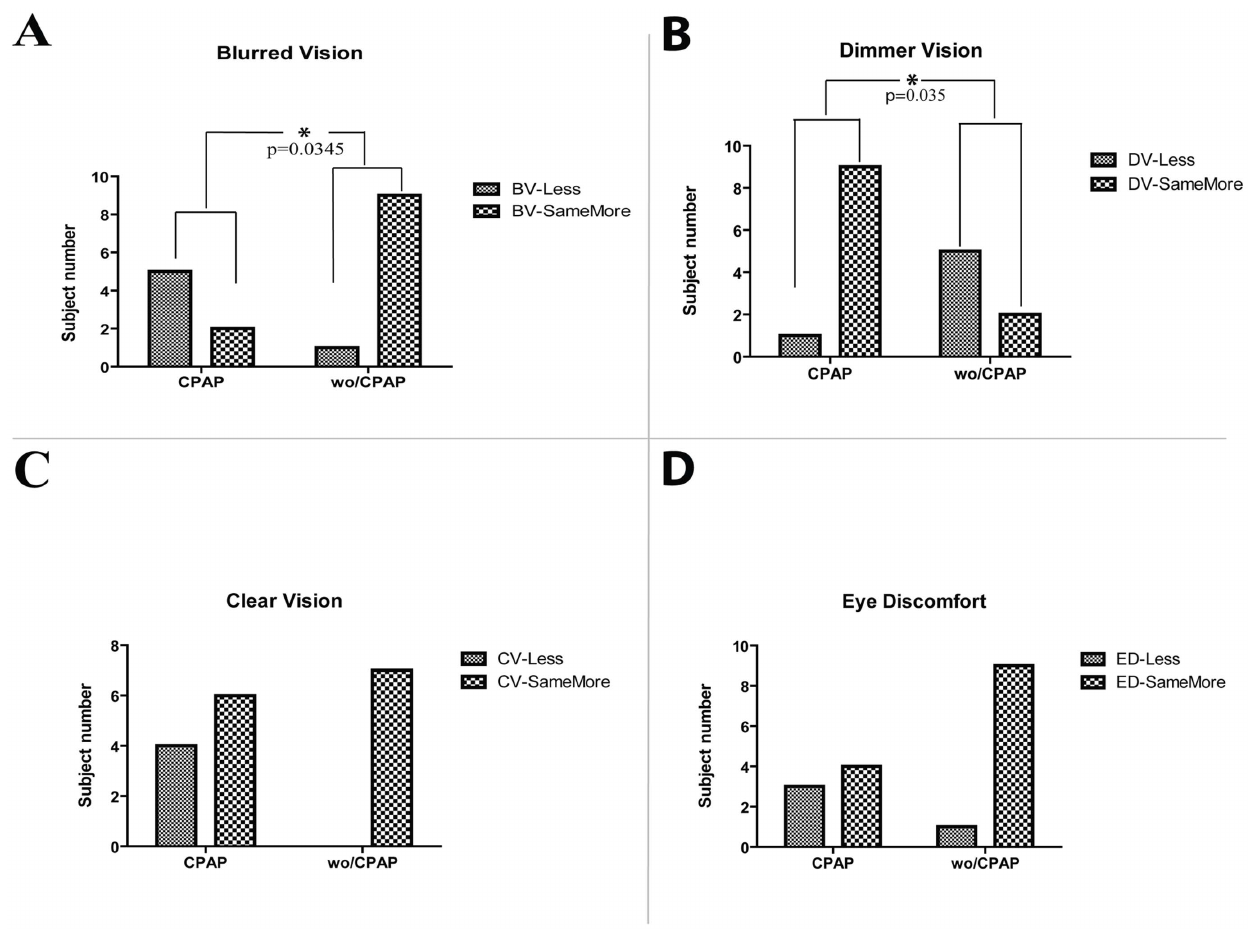
Figure 2 . Results of post-sleep questionnaire of ‘‘with-CPAP’’ (CPAP) and ‘‘without-CPAP’’ (wo/CPAP) groups. The questionnaire is made-up of four categories, which are Blurred Vision (BV) – panel A, Dimmer Vision (DV) – panel B, Clear Vision (CV) – panel C and Eye Discomfort (ED) –panel D. Statistically significant (i.e., accepted as p , 0.05) p values are shown in the figure. Non-significant p values are not shown. The possible three answers to each of the categories are summarized as ‘‘Less answer’’= ‘‘Less’’, ‘‘Same answer’’ = ‘‘SameMore’’ and ‘‘More answer’’ = ‘‘SameMore’’ to make an easy interpretation of data.